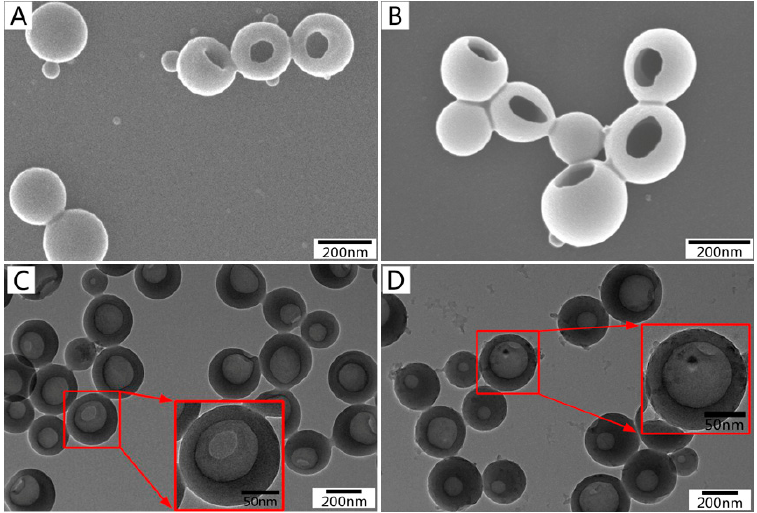
Figure 2. SEM images of ( A ) lignin-based hollow nanoparticles (LHNPs) and ( B ) CD-LHNPs, and TEM images of ( C ) LHNPs, and ( D ) CD-LHNPs.